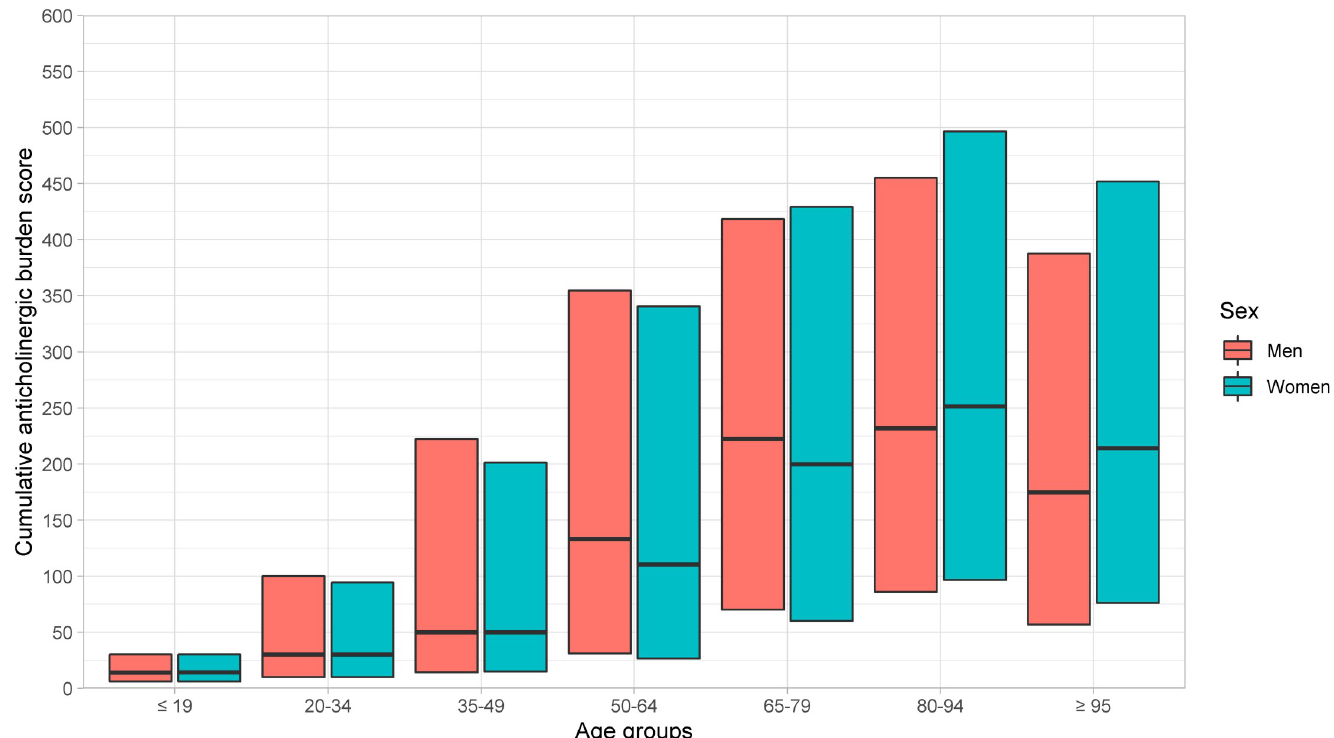
Fig 4. Median (Q1-Q3) cumulative anticholinergic burden, by sex and age.